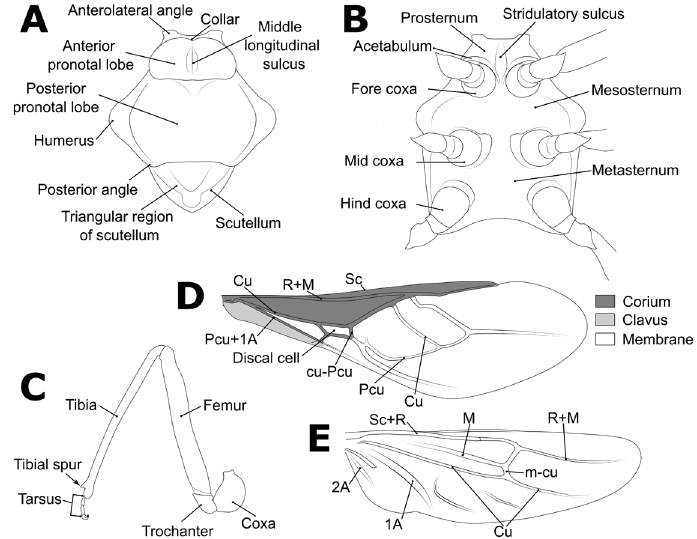
Figure 2. Structure and morphological terms of Biasticus species. Drawing based on Biasticus luteicollis Ha, Truong & Ishikawa, sp. nov., paratype, ♀ , HNL2018-024 A pronotum and scutellum in dorsal view B thorax in ventral view C right fore leg in anterior view D right hemelytron in dorsal view E right hind wing in dorsal view.